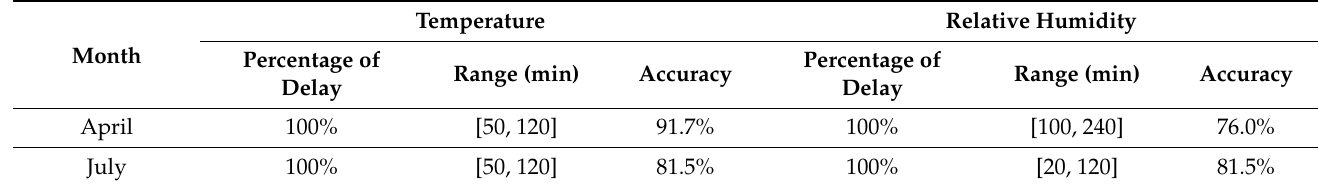
Figure 8. Histogram of the peak delays of ( a ) temperature in April; ( b ) relative humidity in April; ( c ) temperature in July; ( d ) relative humidity in July. Table 2. Hygrothermal transfer with its peak delays at different months.